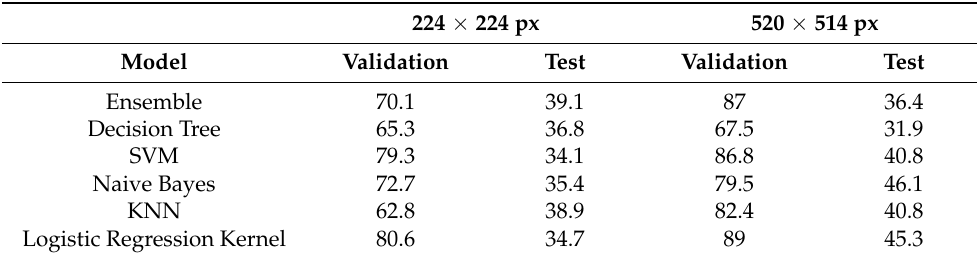
Table 3. Accuracy (%) in classic ML